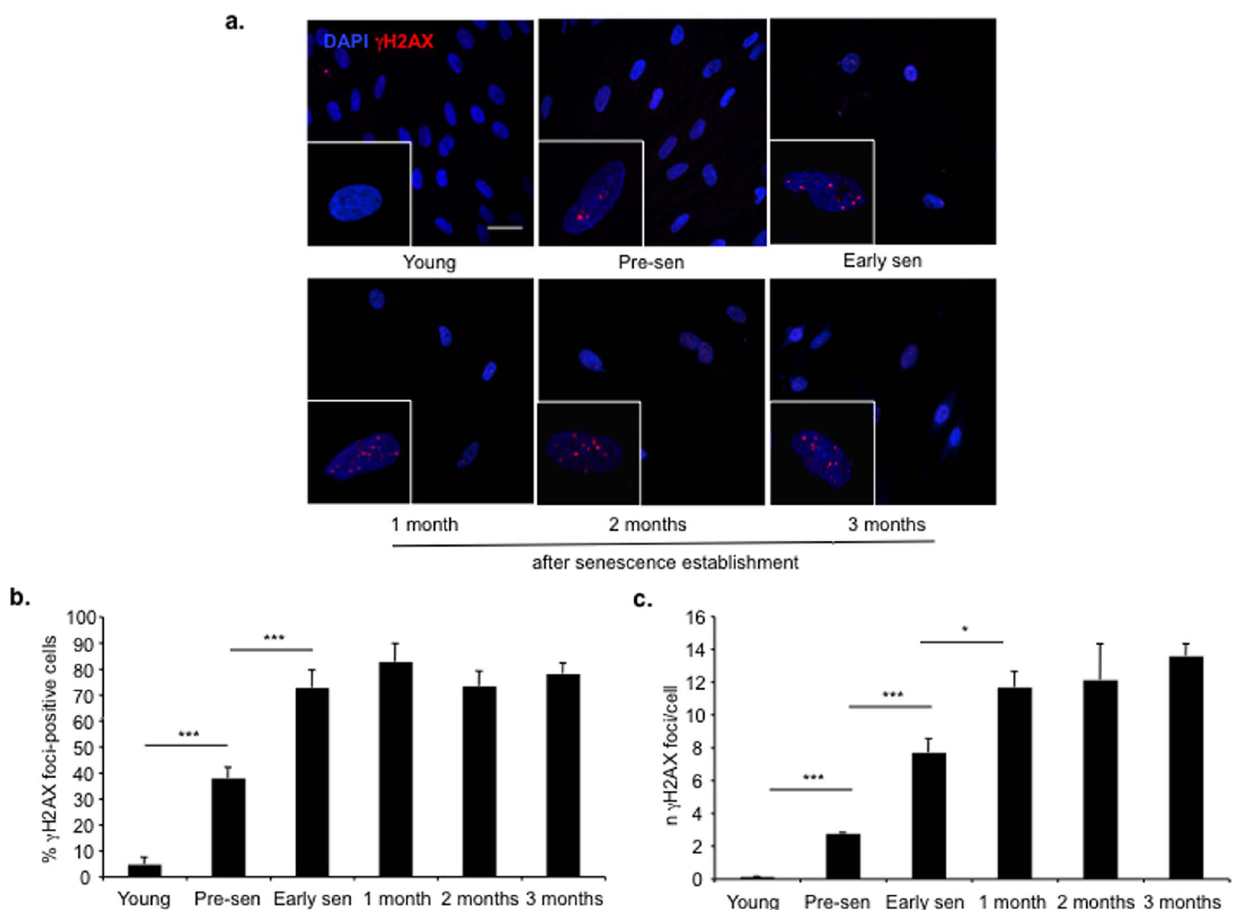
Figure 1. DDR is detectable months after establishment of telomere-initiated cellular senescence. a. In BJ cells, DDR, in the form of c H2AX foci, is detectable long time (up to three months) after establishment of telomere-initiated cellular senescence. Scale bar, 40 m m. b. Bar graph shows the fraction of c H2AX foci-positive cells 6 s.e.m. before (young and pre-sen) and at the indicated time points after senescence establishment. Cells were considered positive if bearing more than 3 DDR foci (*** p-value , 0.001). c. Bar graph shows the average number of c H2AX foci 6 s.e.m. per cell at the indicated time points before and after senescence establishment (*** p-value , 0.001; * p-value , 0.05).